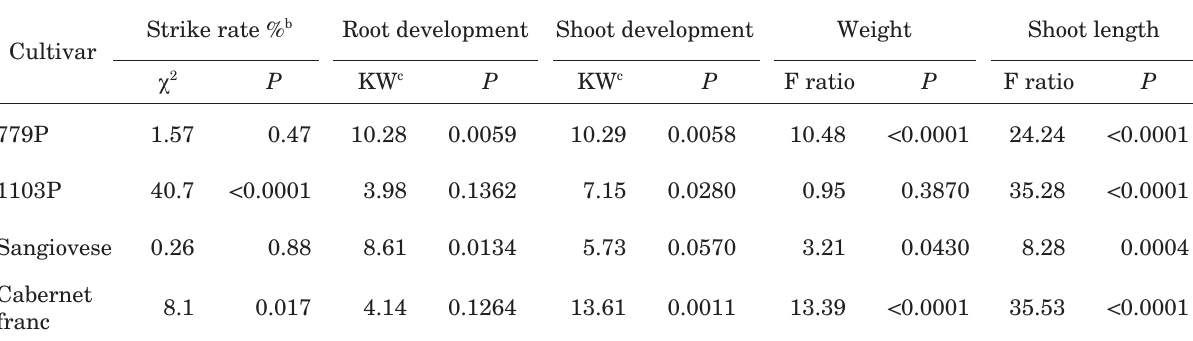
Table 5. Statistical analysis a for growth parameters of vines obtained from 779P, 1103P, Sangiovese and Cabernet franc cuttings treated with hot water before or after cold storage, or untreated in 2007.